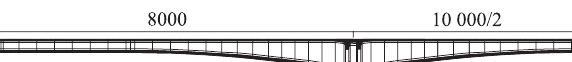
Fig. 6. Box girder section in cm